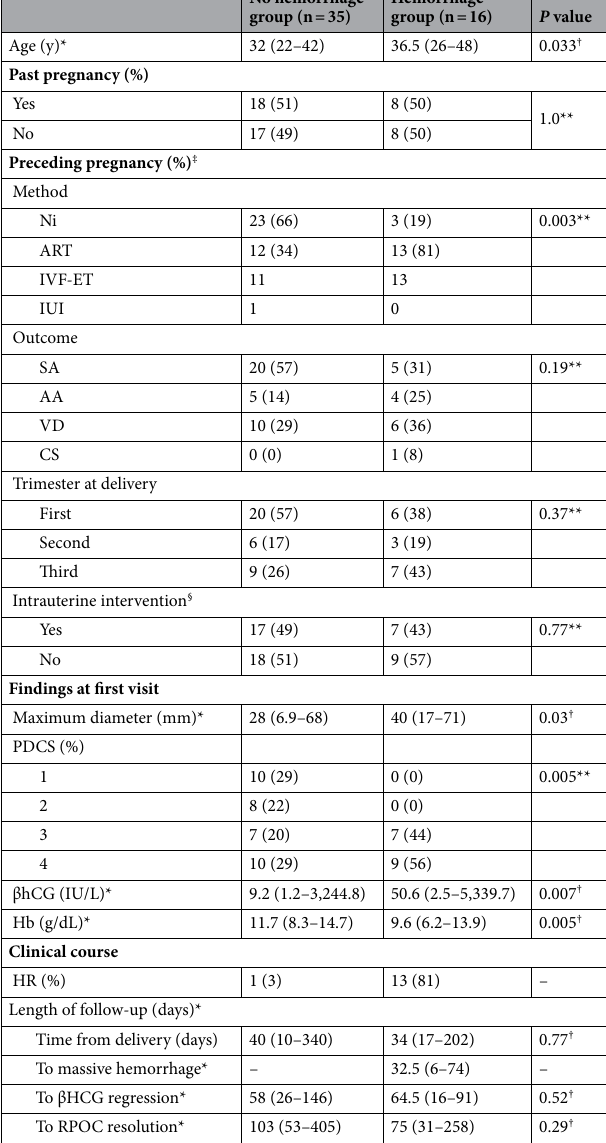
Table 1. Patient characteristics. Comparison between the no hemorrhage and hemorrhage groups. Ni, natural intercourse; ART, assisted reproductive technology; IVF-ET, in vitro fertilization-embryo transfer; IUI, intrauterine insemination; SA, spontaneous abortion; AA, artificial abortion; VD, vaginal delivery; CS, cesarean section; PDCS, power Doppler color scoring; βhCG, serum β-human chorionic gonadotropin; Hb, serum hemoglobin; HR, hysteroscopic resection. *median (range), ‡ pregnancy responsible for RPOC, § dilatation and curettage and manual removal of placenta, † Mann–Whitney U Test, **Fisher exact test. Statistical significance was set at a P value of <